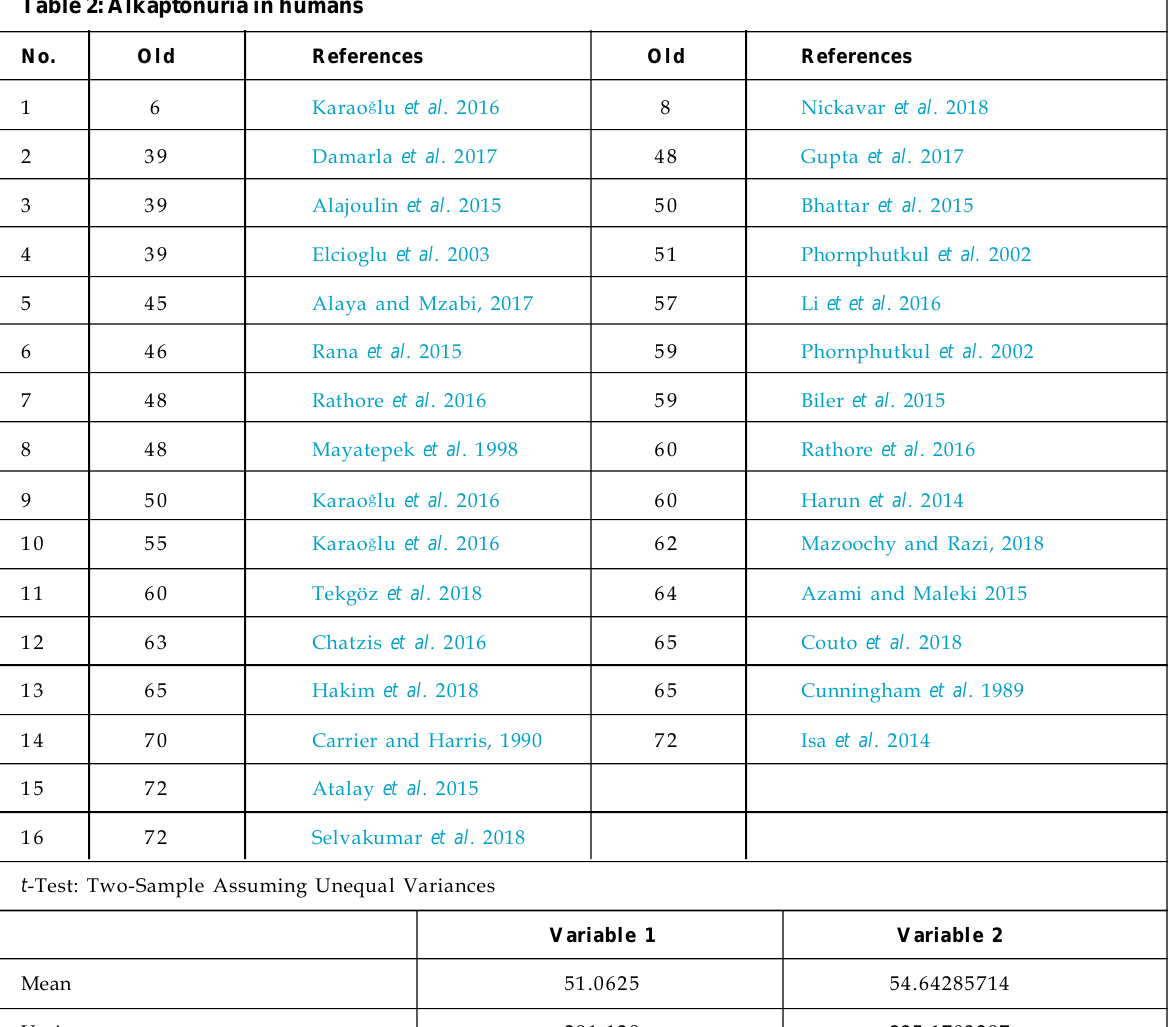
Table 2: Alkaptonuria in